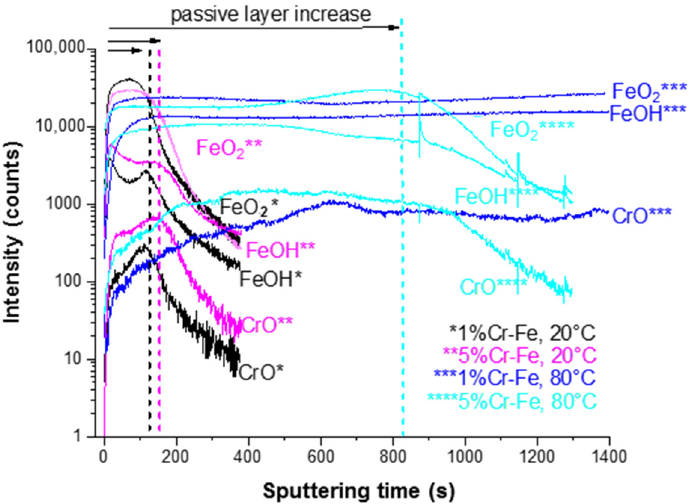
Figure 12. ToF-SIMS negative ion depth profiles for the Fe-1% Cr and Fe-5% Cr samples after polarization (chronoamperometric measurements) at 20 and 80 °C.